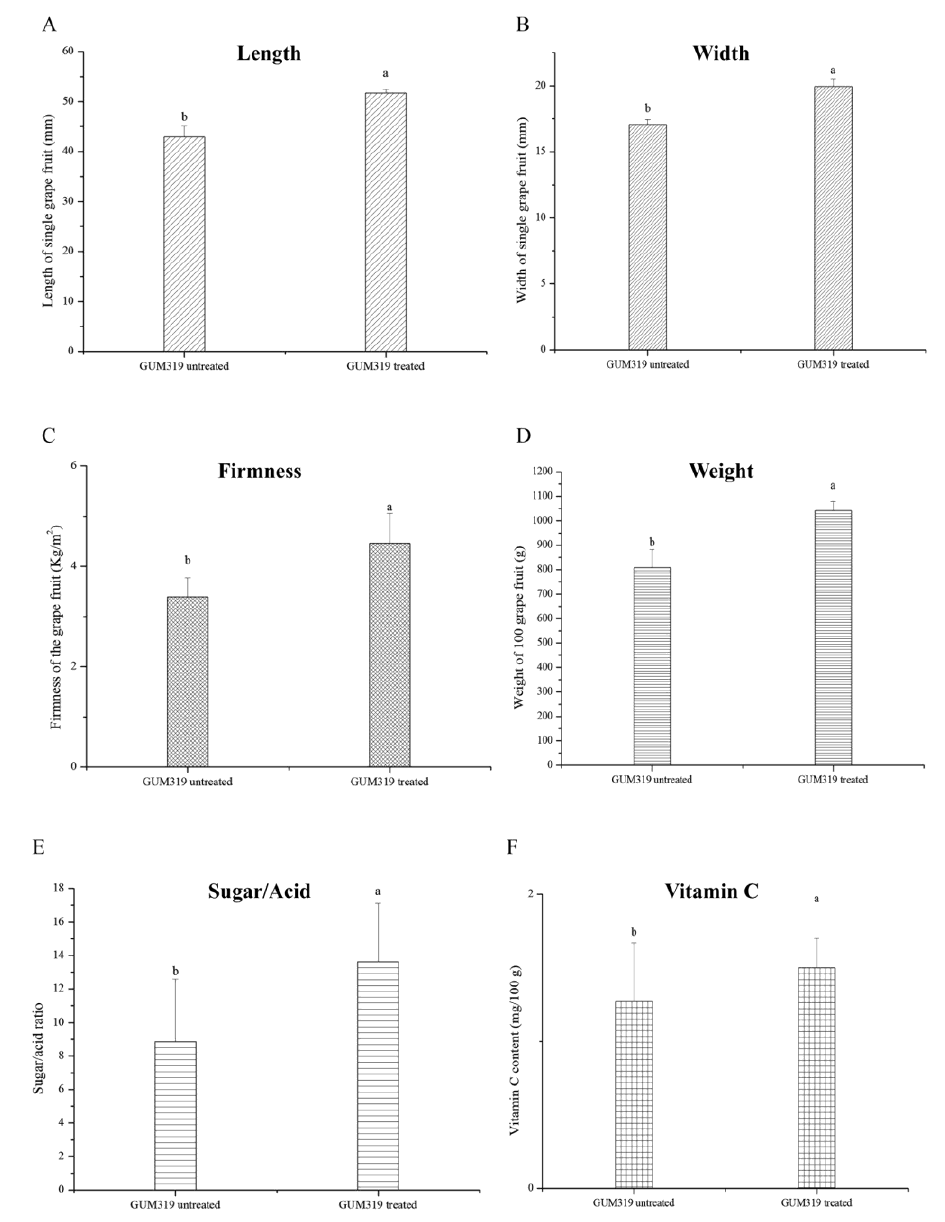
Figure 2. Grape fruit parameters. The error bars represent standard deviation (SD). ( A ) Length of single fruit: GUMT319 untreated 42.94 ± 2.19 b, and GUMT319 treated 51.68 ± 0.83 a (mm). ( B ) Width of single fruit: GUMT319 untreated 17.06 ± 0.39 b, and GUMT319 treated 19.94 ± 0.59 a (mm). ( C ) Firmness of grape fruit: GUMT319 untreated 3.39 ± 0.38 b, and GUMT319 treated 4.46 ± 0.60 a (Kg/m 2 ). ( D ) Weight of 100 grape fruits: GUMT319 untreated 808.03 ± 74.73 b, and GUMT319 treated 1040.87 ± 37.42 a. ( E ) Sugar/acid ratio: GUMT319 untreated 8.85 ± 4.23 b, and GUMT319 treated 13.64 ± 3.48 a. ( F ) The content of vitamin C: GUMT319 untreated 1.27 ± 0.40 b, and GUMT319 treated 1.50 ± 0.20 a.